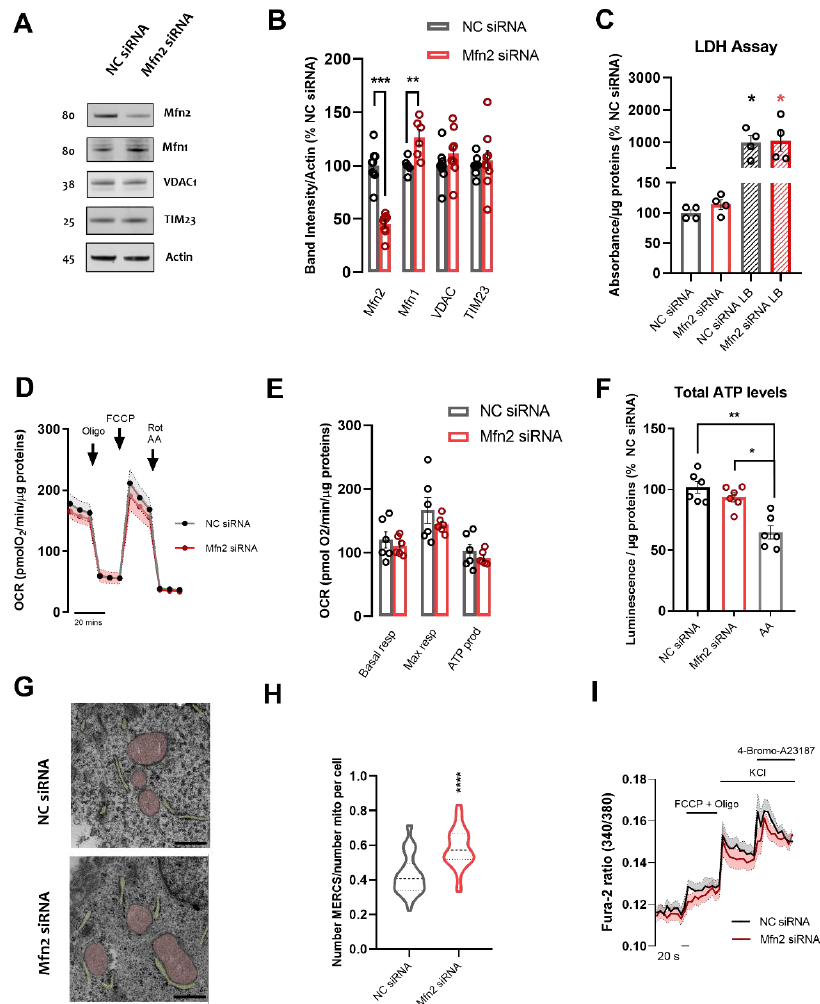
Figure 1. Mfn2 down-regulation increases ER–mitochondria juxtaposition while not affecting cellular nor mitochondrial viability, nor cytoplasmic Ca 2+ dynamics. ( A ) Representative immunoblots of SH-SY5Y cell homogenate treated with NC siRNA or Mfn2 siRNA. Blots were probed with antibod- ies against Mfn2, Mfn1, VDAC1, and TIM23, and Actin was used as a loading control. ( B ) Bar graph shows the amounts of protein analyzed once standardized to actin content in each sample ( n = 9 independent cultures) ( C ) Bar graph shows quantification of LDH assay absorbance normalized to protein content in NC siRNA or Mfn2 siRNA cultures; a Lysis Buffer (LB) was used as a positive control to elicit LDH release ( n = 4 independent cultures) ( D ) Oxygen consumption rate (OCR) traces showing cellular respiration in NC siRNA or Mfn2 siRNA treated SH-SY5Y cells after the sequential injection of oligomycin (oligo,1 µM), FCCP (1 µM) and Rotenone + Antimycin A (Rot+AA, 0.5 µM) ( n = 6 independent cultures) ( E ) Bar graphs show quantification of OCR parameters extrapolated from Seahorse XF Cell Mito Stress Test and normalized to protein content, including basal respira- tion (Basal Resp), maximal respiration (Max Resp) and ATP production (ATP prod) ( F ) Bar graph shows quantification of ATP luminescence normalized to protein content in NC siRNA or Mfn2 siRNA cultures; 5 µM AA was used as a negative control by incubating non treated cells for 1 h prior to analysis ( n = 6 independent cultures) ( G ) Representative TEM pictures of NC siRNA or Mfn2 siRNA SH-SY5Y cells showing mitochondria (pink) and ER (yellow) in close proximity to each other forming MERCS. Scale bar = 500 nm. ( H ) Violin plot shows quantification of number of MERCS per number of mitochondria per cell (4 independent cultures, 9–10 cells analyzed per culture). ( I ) Quantification of cytosolic Ca 2+ Fura-2/AM fluorescence transients at baseline and peak amplitude upon differ- ent stimuli ( n = 5–7 independent cultures). Data shown as mean ± SEM. * p ≤ 0.05, ** p ≤ 0.01, *** p ≤ 0.001, **** p ≤